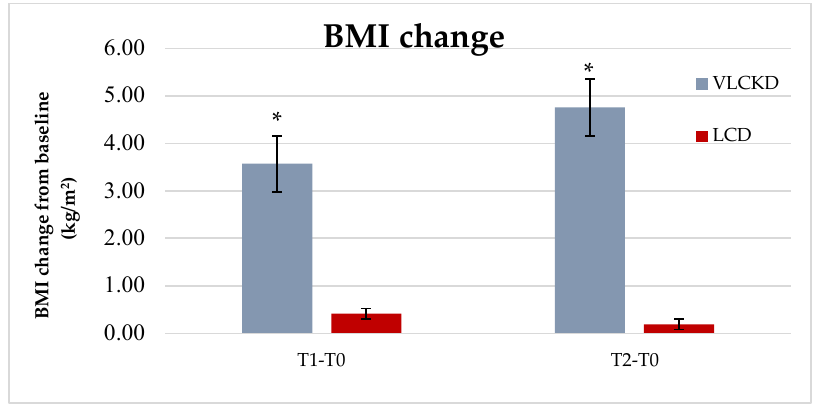
Figure 2. Mean BMI (±SE) reduction at T1 (3 months) and T2 (12 months) in VLCKD and LCD groups . * p < 0.001.